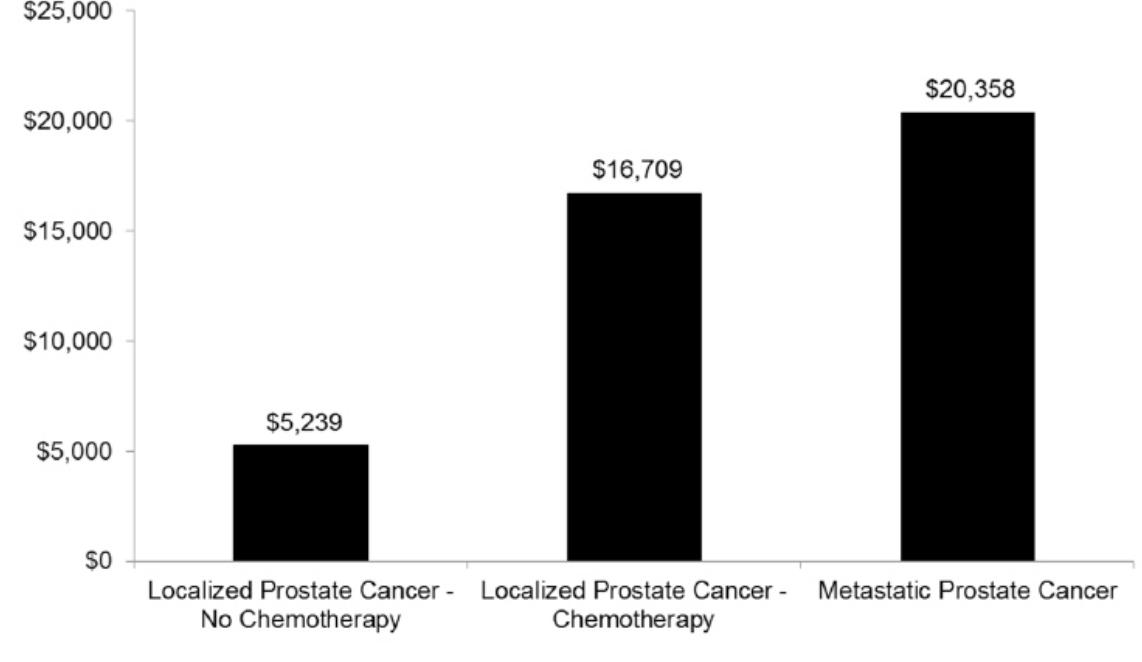
Figure 2. Total incremental individual expenditures in 2011 US